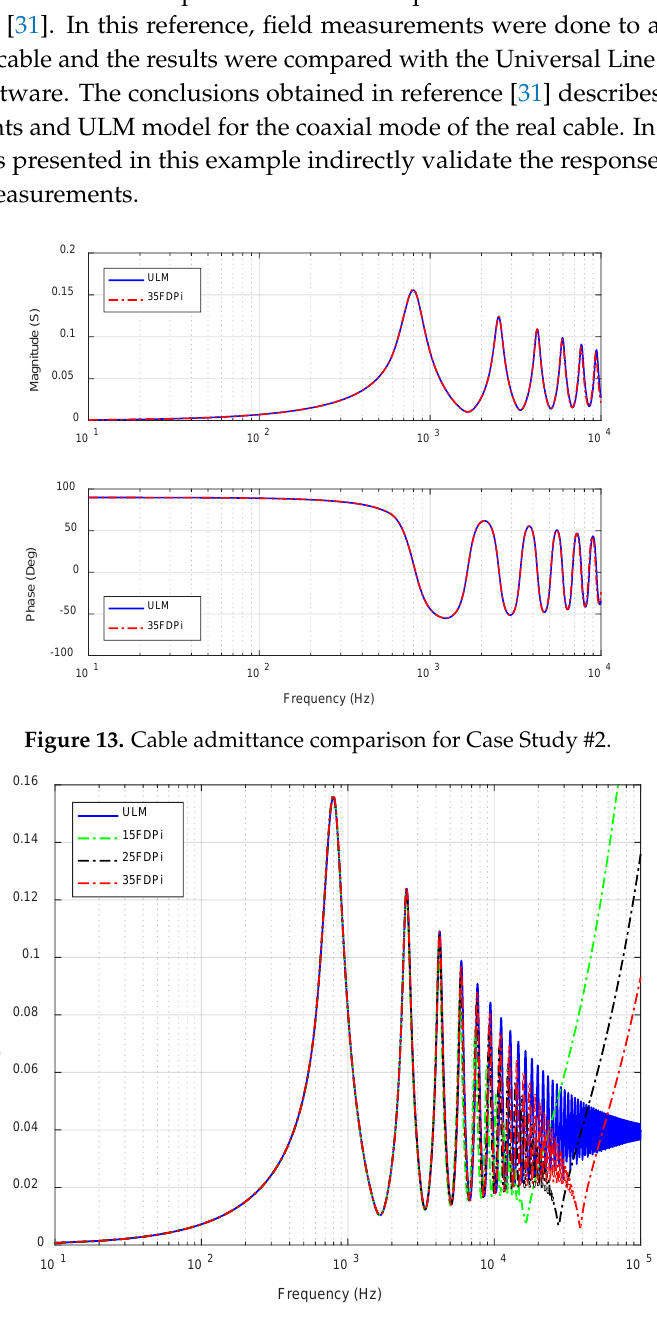
Figure 14. Cable admittance comparison for Case Study #2 with different number ( N ) of cascaded FDPi sections.